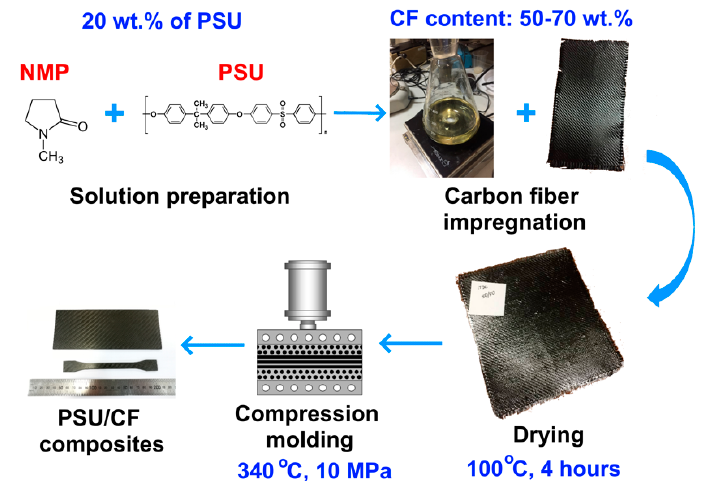
Figure 1. Scheme of the preparation of the carbon fiber reinforced polysulfone based composites.